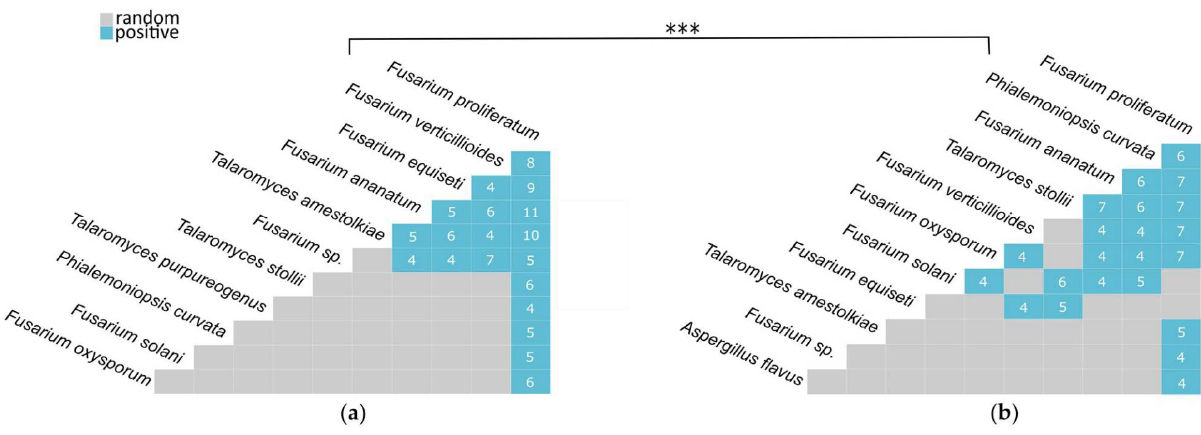
Figure 6. Matrixes of fungal species co-occurrences determined in healthy (a) and infected fruitlets (b) based on a pairwise approach. Significant positive associations are indicated in blue with the corresponding number of observations. Random associations are indicated in grey. The correlation between matrixes was assayed by the Mantel test (*** significance at p ≤ 0.001).